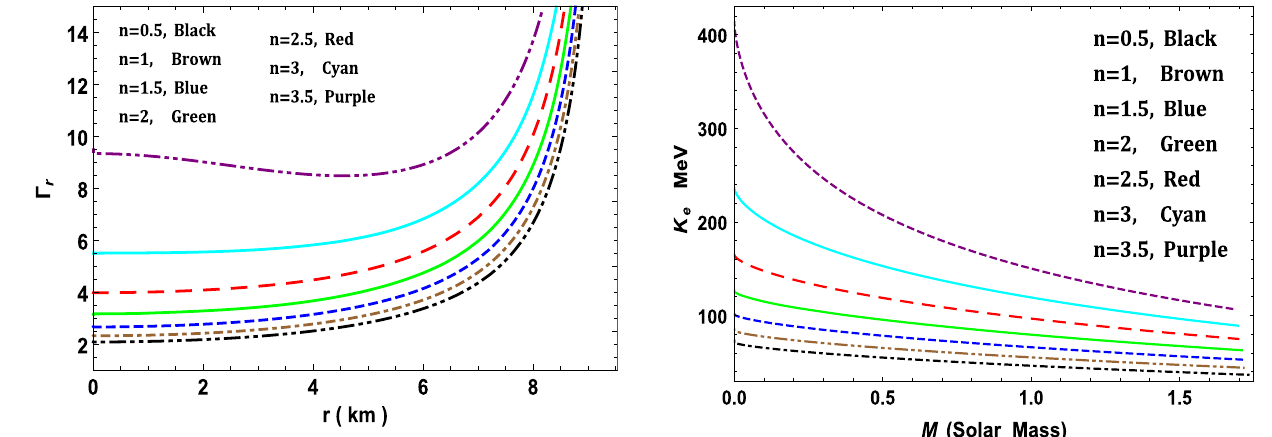
Fig. 16 K e – M graph r for 4U 1608-52 ( M = 1 . 74 M (cid:9) , R = 9 . 528 km) by taking a = 0 . 001 km − 2 and β = 0 . 01